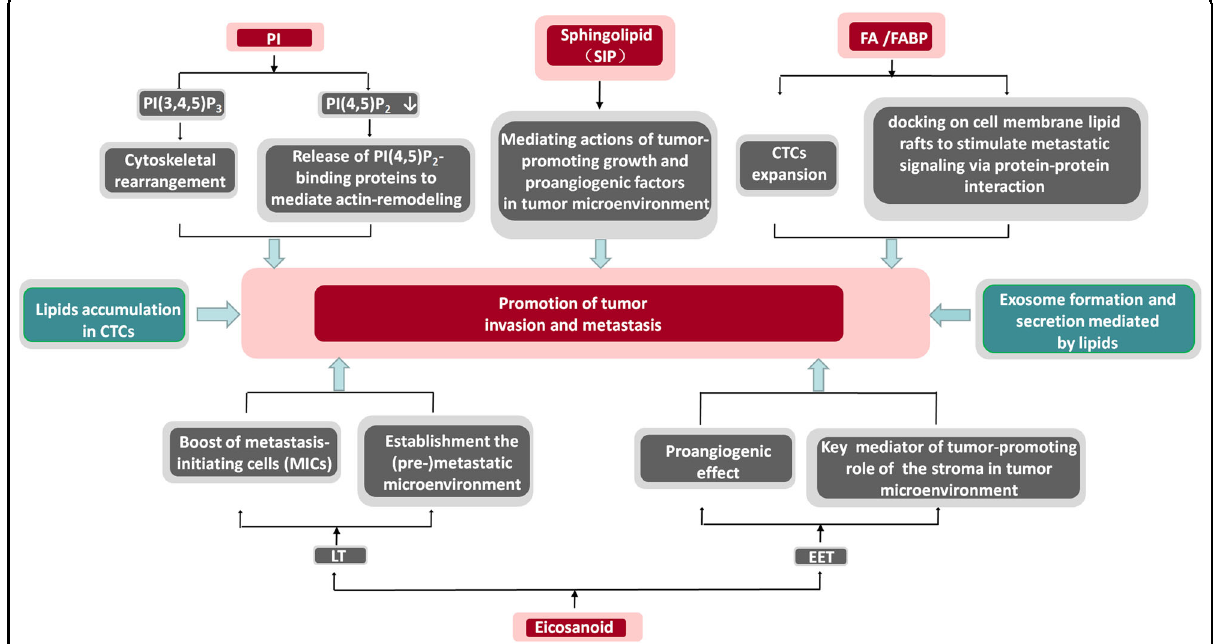
Fig. 1 Schematic of signaling lipids implicated in cancer invasive and metastatic progression and the mechanism of action. CTC circulating tumor cell, EET epoxyeicosatrienoic acid, FA fatty acid, FABP fatty acid-binding protein, LT leukotriene, PI phosphatidyl inositides, S1P sphingosine-1-